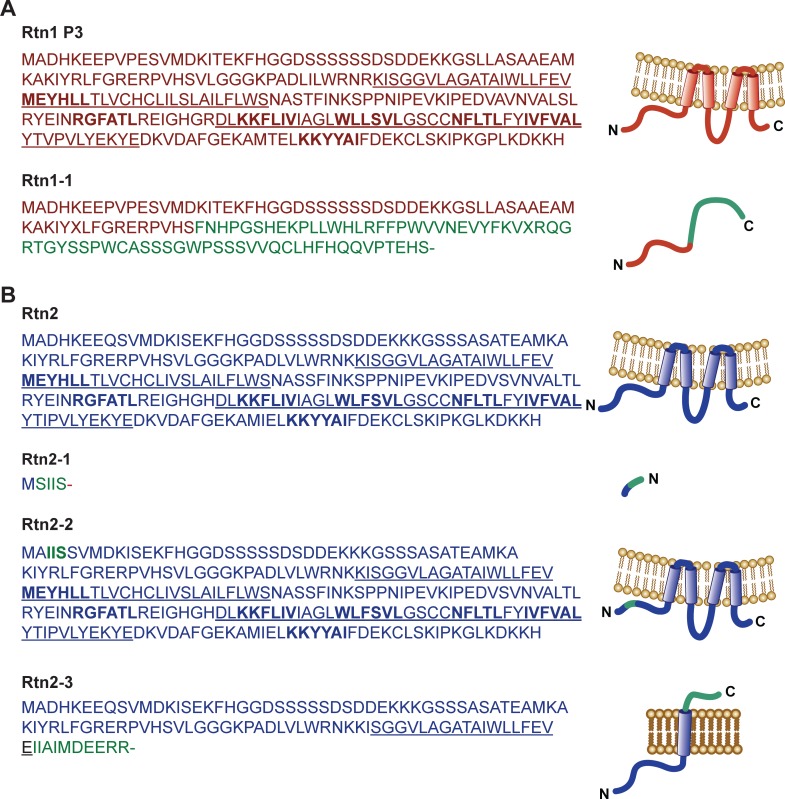
Predicted amino acid sequences of Rtn1 and Rtn2 polypeptides.Amino acid sequences predicted from translated transcripts of wild type and mutant versions of Rtn1 (A) and Rtn2 (B). The mRNAs were isolated from W22, Mu-08559 (rtn1-1), Mu-02254 (rtn2-1), Mu-03723 (rtn2-2), and Mu-00381 (rtn2-3). Underlined sequences correspond to transmembrane regions; coloured amino acids correspond to mutated sequences; bold amino acids indicate predicted AIMs.